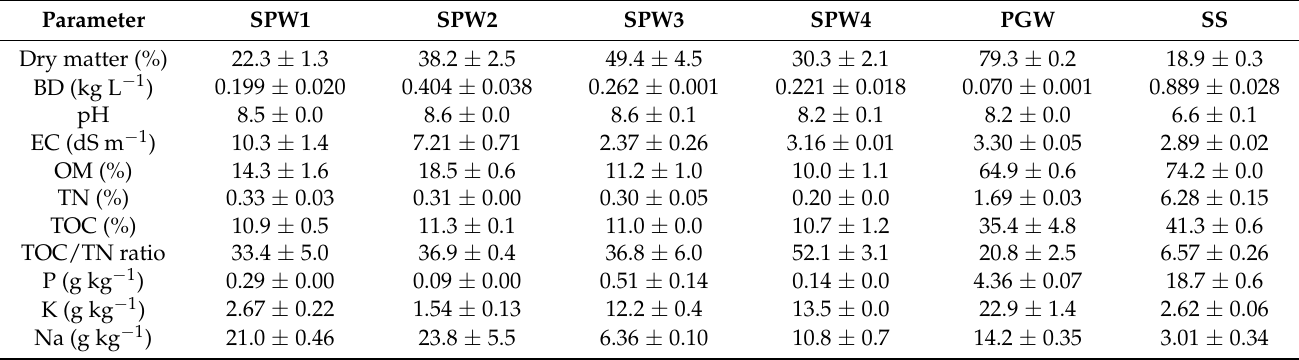
Table 1. Main characteristics (dry weight basis) of the initial materials used in the co-composting scenarios. Parameter